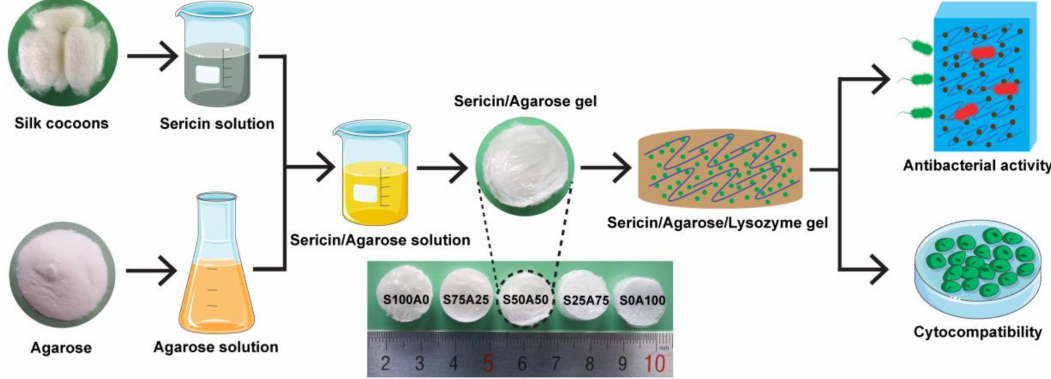
Figure 1. Schematic illustration of the fabrication of sericin (SS)/agarose (AR)/lysozyme (LZM)